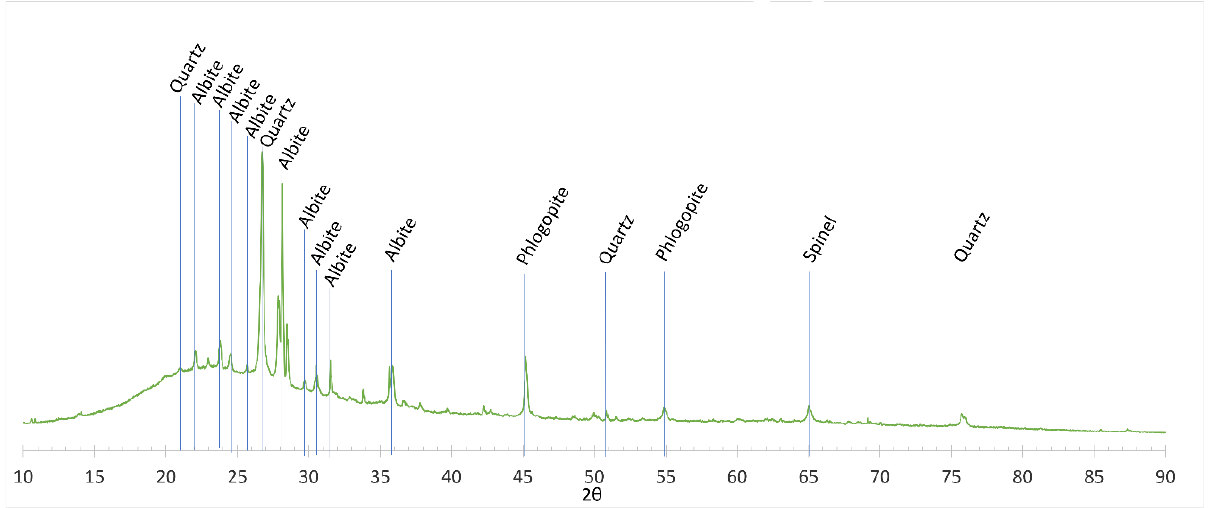
Figure 3. XRD pattern of liberated white particles in the raw PMMN with identified peaks.